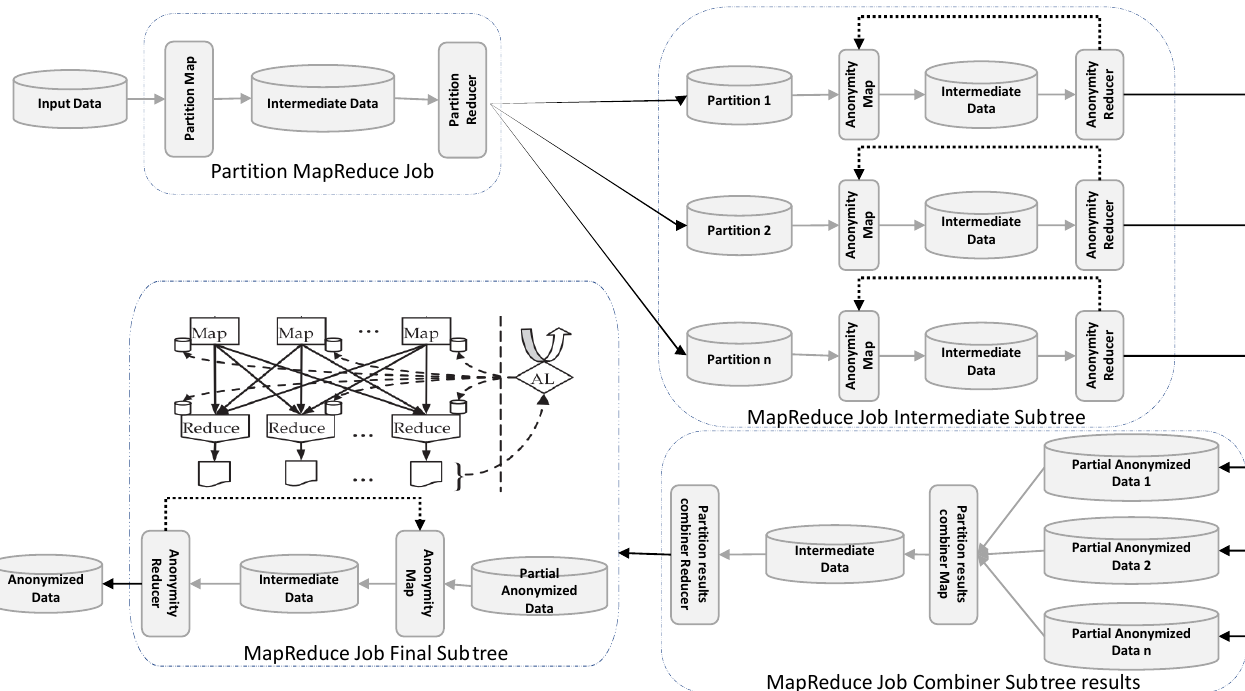
Figure 2. Subtree data-flow diagram in the MapReduce